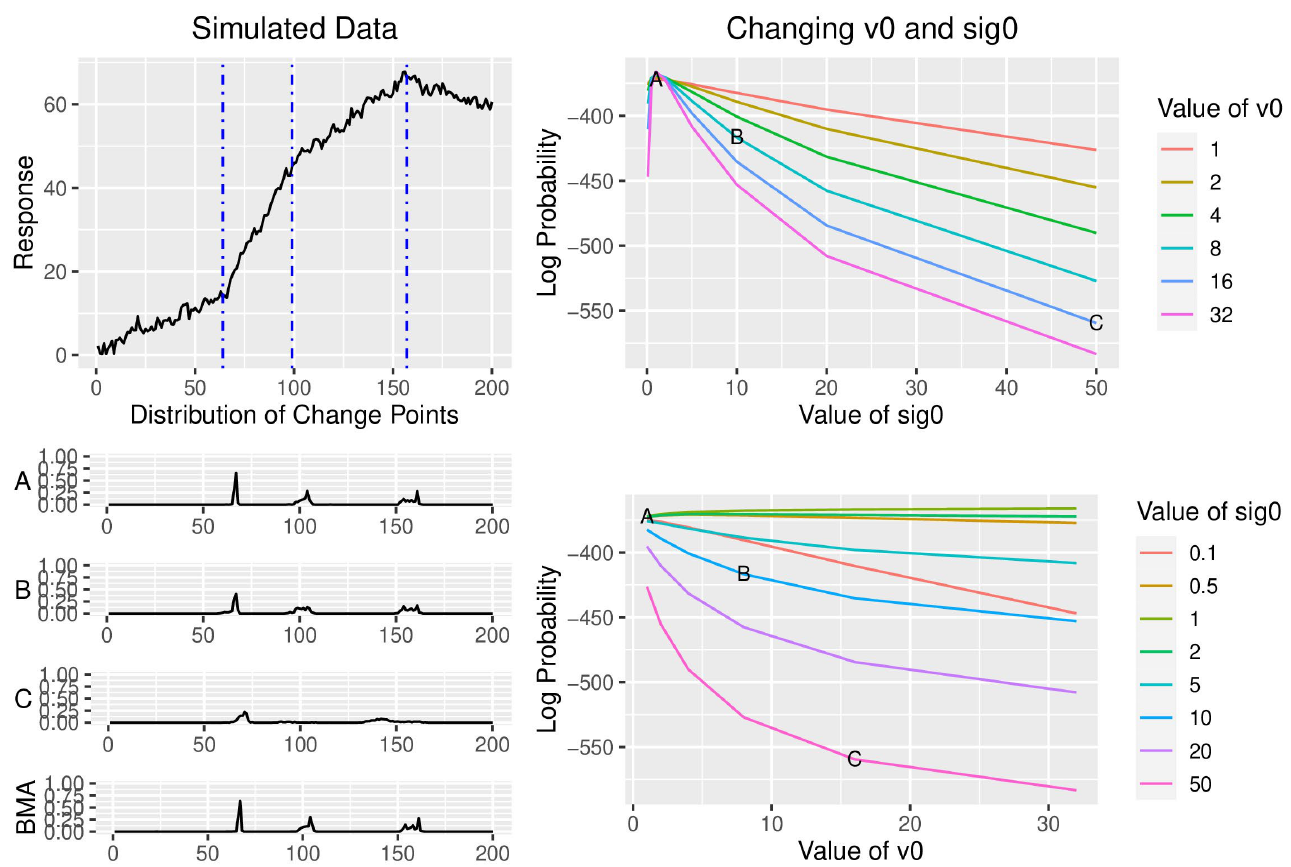
Figure 4. How v 0 and σ 2 Affect the Posterior Distribution. The top left displays a dataset generated according to the process described in Section 3.1, along with the location of each change point, indicated as a dotted vertical line. The log probability of the data, i.e., P ( M i | Y ) , is shown on the right for various combinations of v 0 and σ 2 . Three sets of hyperparameters, labeled A, B, and C, are selected and their posterior distribution of the location of change points is shown in the bottom left, along with the posterior distribution for the BMA solution, which weights each solution according to its probability.